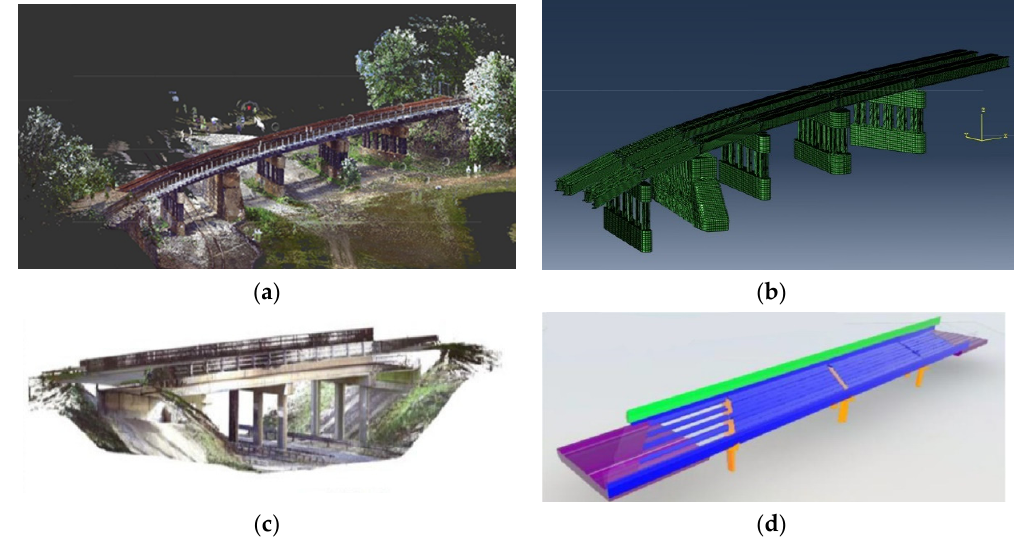
Figure 6. Generation of 3D models from the point data sets: ( a ) Robot City bridge point cloud, Pennsylvania [80]; ( b ) 3D finite element model of the Robot City bridge [80]; ( c ) Dunsley corner bridge point cloud, Cambridge [79,80]; ( d ) 3D solid model of Dunsley corner bridge [80].